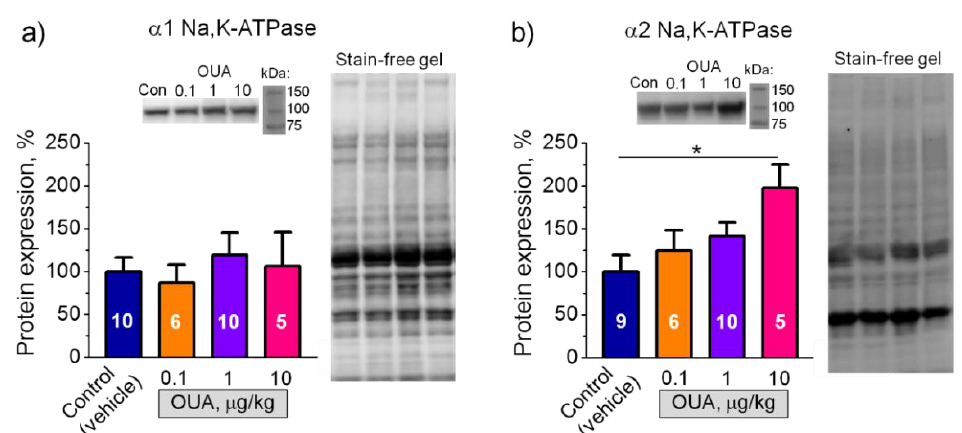
Figure 6. Effects of chronic exposure to ouabain on the protein content of α1 ( a ) and α2 ( b ) Na,K-ATPase in homogenate of rat soleus muscles. Rats were injected for 4 days with different doses (µg/kg) of ouabain as indicated. Control rats were injected with vehicle (0.9% NaCl). ( a ) and ( b ) Averaged Western blot results of the α1 and α2 isoform protein expression, respectively (the number of rats n = 5–10, as indicated); representative Western blots for semi-quantification of the Na,K-ATPase α1 and α2 isoforms are shown. Original images for Western blots using Stain-Free gels as a loading control are shown in Supplemental Materials . One-way ANOVA. * p < 0.05—compared with the control (vehicle treated group).